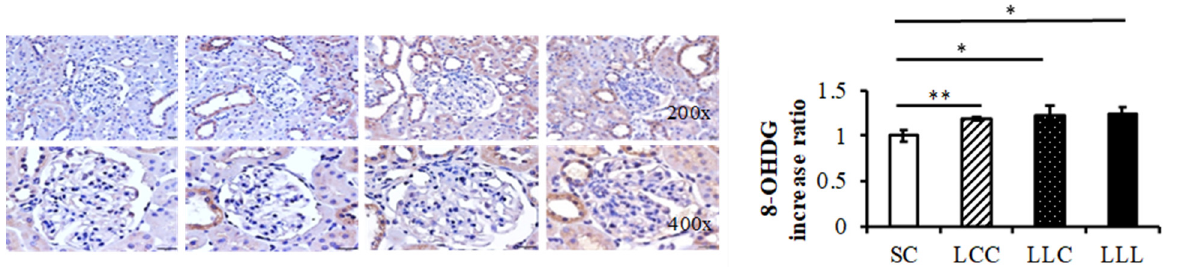
Figure 6. Offspring renal cortex 8-OHdG stain. Four groups were evaluated by one-way ANOVA with the LSD post hoc test. * vs. SC, p < 0.05; ** vs. SC, p < 0.01.